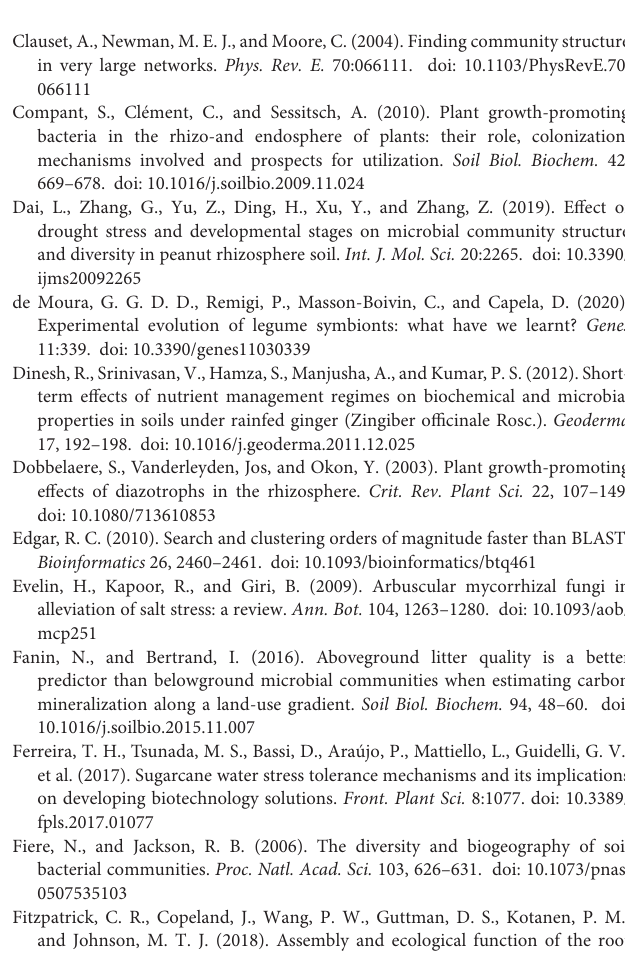
Supplementary Figure 1 | Soil moisture content during sugarcane planting. Supplementary Figure 2 | Correlation of alpha-diversity index with environmental factor. Correlation of alpha-diversity index with soil properties (A,C) and physiological shape (B,D) of sugarcane (Chao 1 ≥ 0; Shannon ≥ 0). Supplementary Figure 3 | OTUs proportional Venn diagram of sugarcane rhizosphere under different treatments. Supplementary Figure 4 | Co-occurrence and abundance of dominant bacterium cOTUs in sugarcane rhizosphere. The relative abundances (as counts per million, CPM) of all sensitive OUT in the symbiosis network of rhizosphere microbiome ( Figure 4A ) were plotted as A function of their coexistence degree, under water treatment (A) and under drought treatment (B) . The different colored areas represent the topological roles in the entire co-occurrence network, and the nodes are colored according to the corresponding modules. The lavender region (with the highest co-occurrence of 1%) is the Keystone region with the highest degree of central connection. Supplementary Figure 5 | The relative abundance of biomarkers at the family level of rhizosphere bacteria. Supplementary Figure 6 | The relative abundance of biomarkers at the genus level of rhizosphere bacteria. Supplementary Figure 7 | Correlation analysis of main response flora and environmental factors. ∗ p < 0.05; ∗∗ p < 0.01; and ∗∗∗ p <